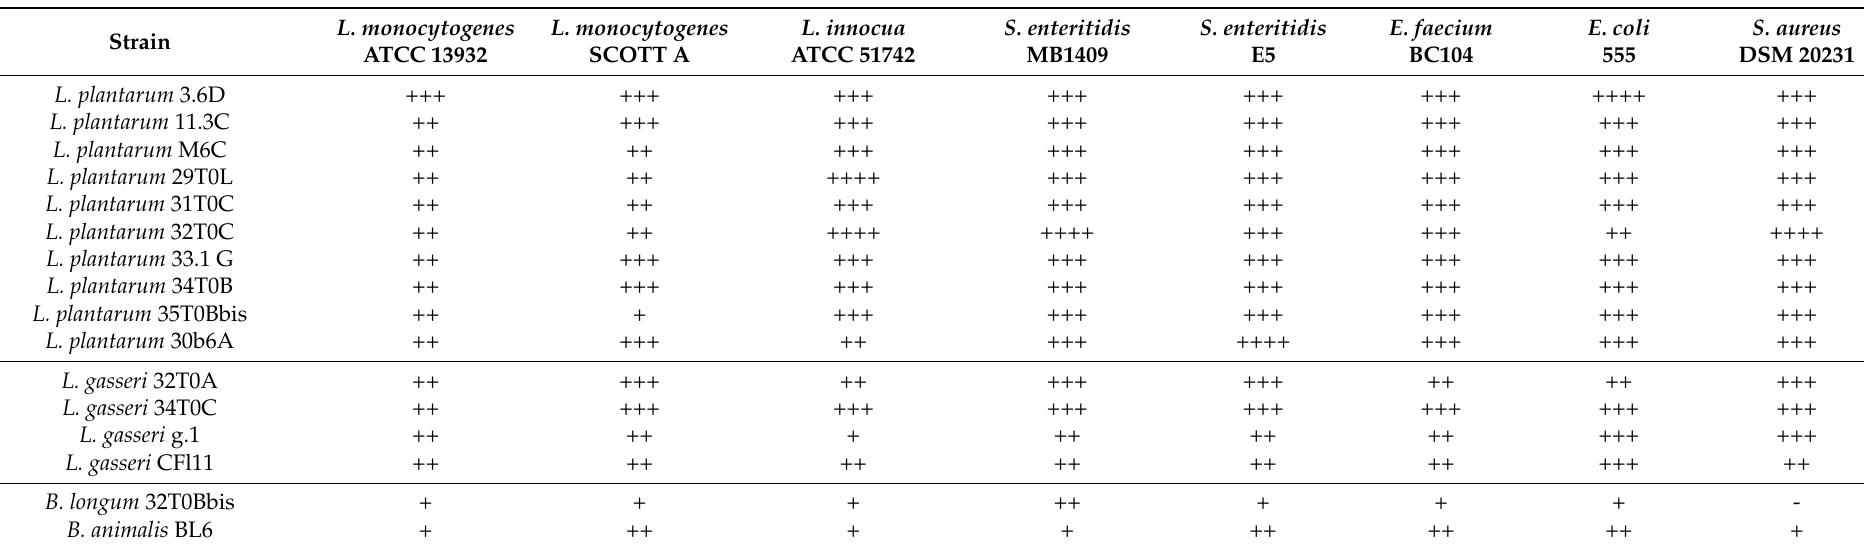
Table 4. Evaluation of the antagonistic activity of the Lactobacillus and Bifidobacterium strains isolated from breast milk and used in the present study against selected pathogenic or spoilage microorganisms related to